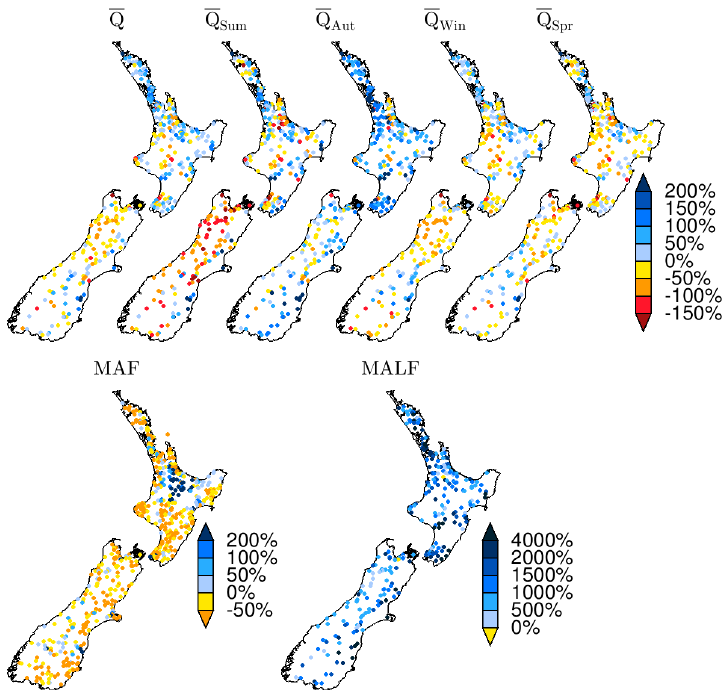
Figure 3. At ‐ site percentage bias (PBIAS) for the seven flow descriptors: Q ̄ , Q ̄ Sum , Q ̄ Aut , Q ̄ Win , Q ̄ Spr , Figure 3. At-site percentage bias (PBIAS) for the seven flow descriptors: Q, Q Sum , Q Aut , Q Win , Q Spr ,